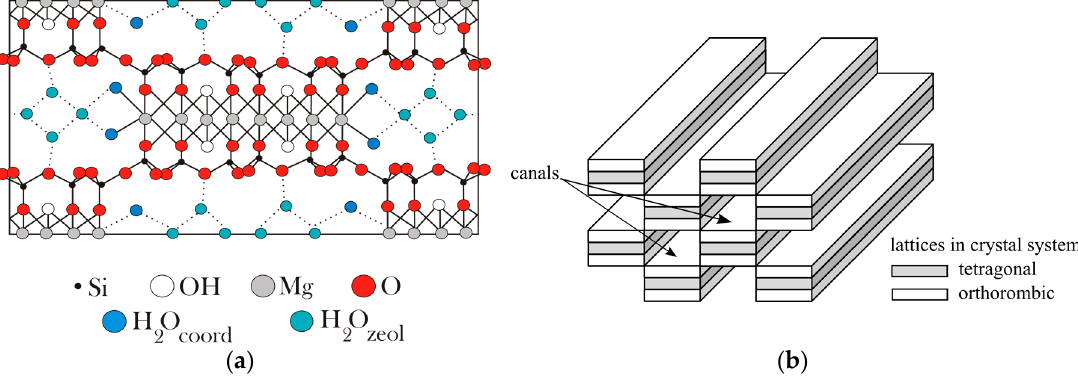
Figure 15. Diagram of the chemical structure of the sepiolite with the adsorbed forms of water ( a ) prepared on the basis of [28]; and ( b ) the channels formed by the combination of unit cells. Various forms of water found in the sepiolite are released at different temperature ranges [7].